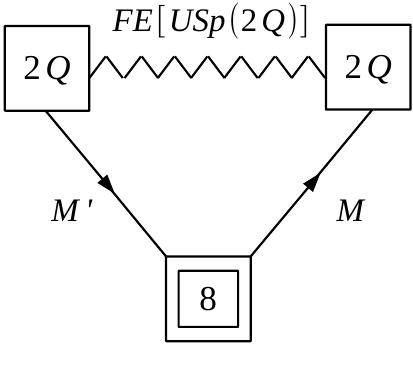
Figure 2: The basic tube theory. It is built from a quiver theory we denote by F E [ USp ( 2 Q )] and two octets of fundamental fields charged under the two USp ( 2 Q ) puncture symmetries. In this drawing simple square boxes represent USp ( 2 Q ) flavor symmetries and the double square box represents an SU ( 8 ) flavor symmetry. More- over, straight lines denote standard 4d N = 1 chiral fields M a , M (cid:48) under the symmetries of the nodes they are connecting, while the wiggle line de- notes a more exotic type of matter which corresponds to the F E [ USp ( 2 Q )] SCFT first introduced in [ 18 ] (see Appendix A for a